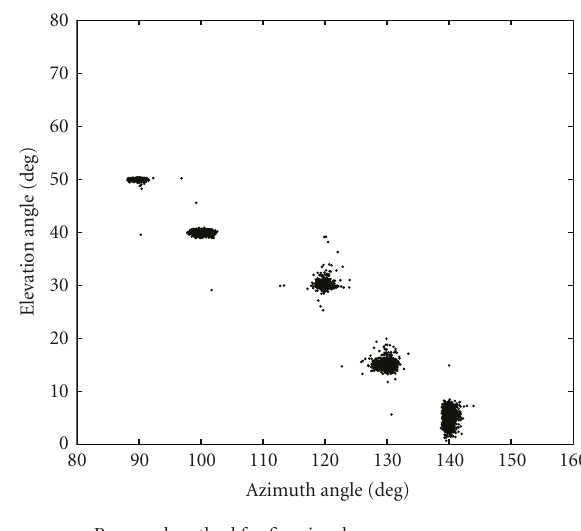
Figure 6: Scatter plot of the elevation angle versus the azimuth angle for 2-D DOA estimation of five equal power signals at [(5 ◦ ,140 ◦ ),(15 ◦ ,130 ◦ ),(30 ◦ ,120 ◦ ),(40 ◦ ,100 ◦ ),(50 ◦ ,90 ◦ )] with 30 dB and 500